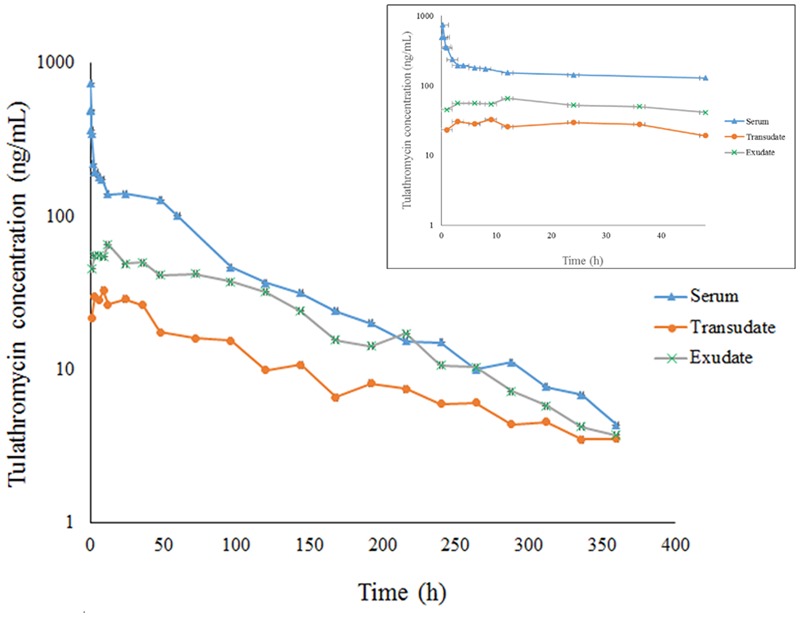
The concentration-time curve for tulathromycin in serum, transudate and exudate after i.m. administration at a dosage of 2.5 mg/kg body weight (for clarity the small graph depicts the drug concentrations in the first 48 h post-administration).